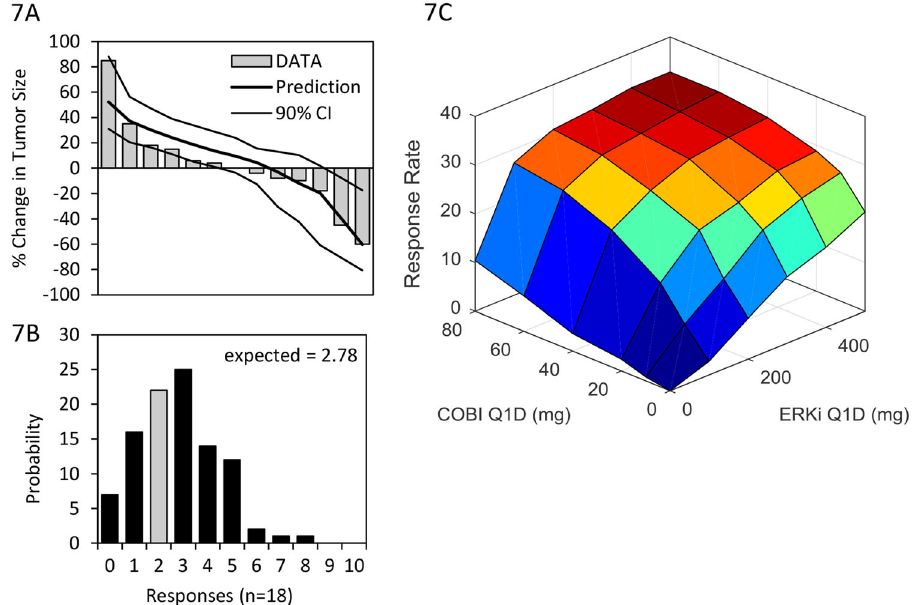
Fig. 7 Clinical trial simulations and data for GDC-0994 monotherapy, and combination with cobimetinib. a Simulated tumor size changes (waterfall plots), and data from 13 evaluable patients treated with GDC-0994. b Simulated distribution of expected responses for an 18 patient clinical trial, gray bar indicating clinical results (2/18). c Simulated ORR to combinations of cobimtenib and GDC-0994